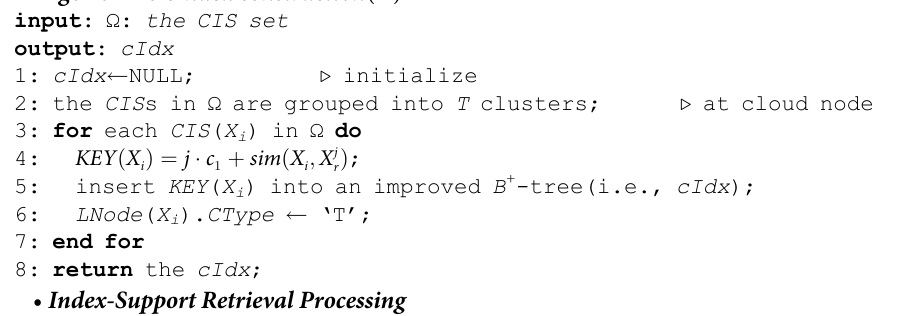
Algorithm 5 cIndex construction ( O